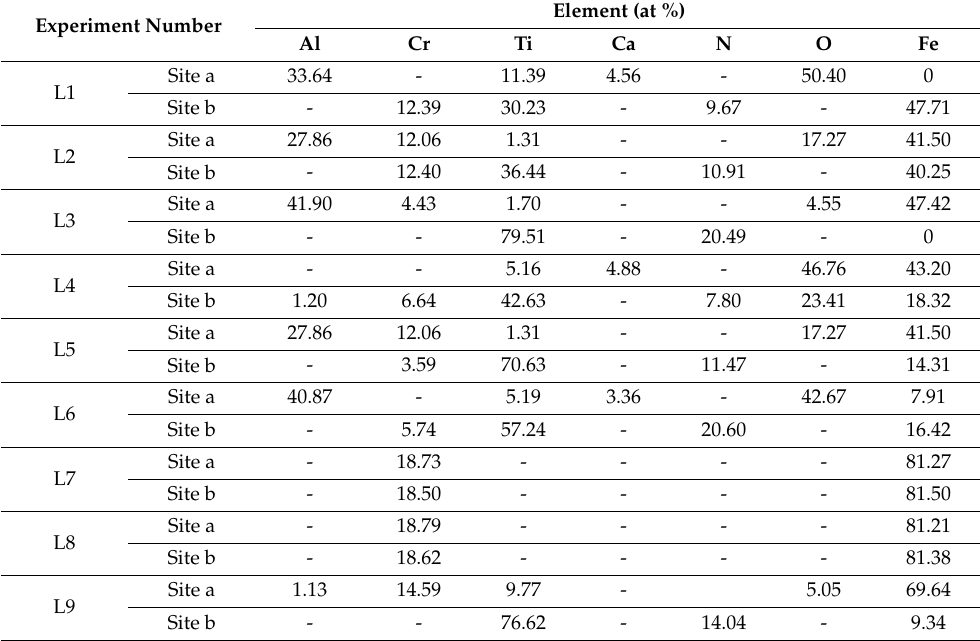
Figure 6. ( a ) Photographs and ( b ) SEM images of steel nozzles L1–L9. The composition of sites a and b in ( b ) was shown in Table 2. Table 2. EDS results obtained from the clogs in steel nozzles L1–L9 (the sites detected are shown in Figure